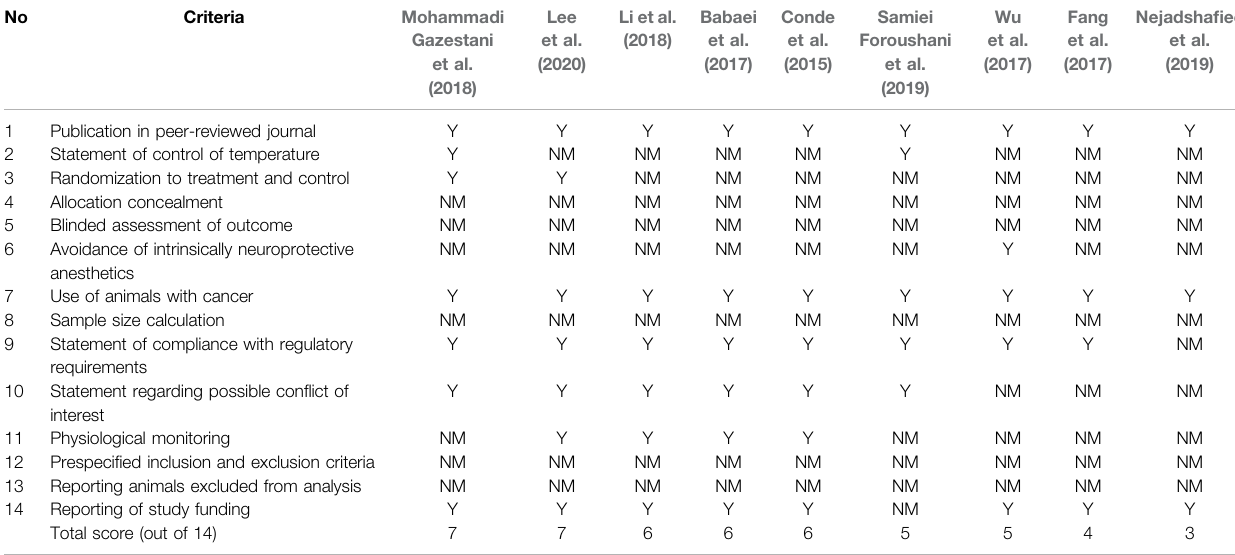
TABLE 4 | Quality assessment using CAMARADES